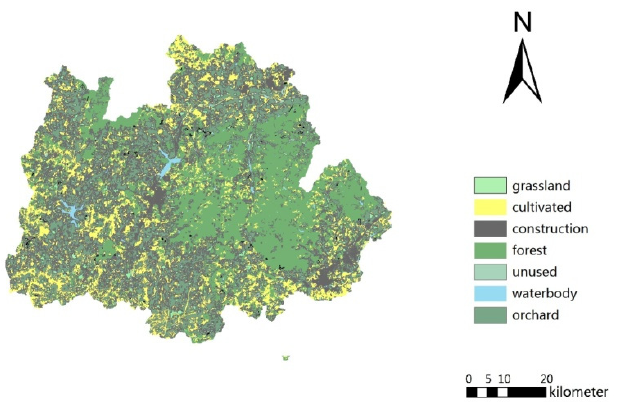
Figure 2. Land-use classification of Qixia. Table 2. Comparison of fertilizer and pesticide usage in Qixia County, Shandong Province, and China. Qixia County Shandong Province (2018) China (2018)